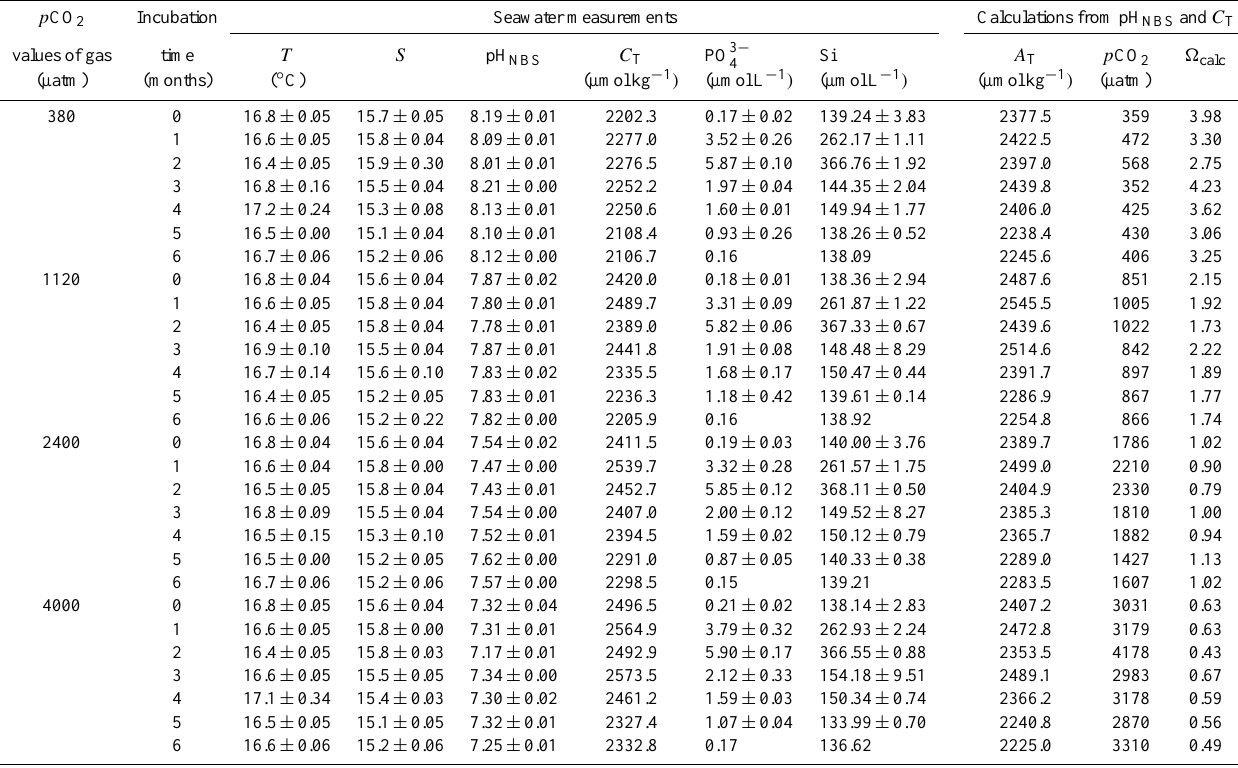
Table 2. Carbonate chemistry parameters of each p CO 2 treatment in the culture vessels. Total alkalinity ( A T ) , partial pressure of CO 2 (p CO 2 ) and saturation state of calcite ( (cid:127) calc ) were calculated from measured temperature, salinity, pH NBS , total carbon ( C T ) , phosphate (PO 3 − and silicate (Si). The SD (1 σ ) refers to replicate